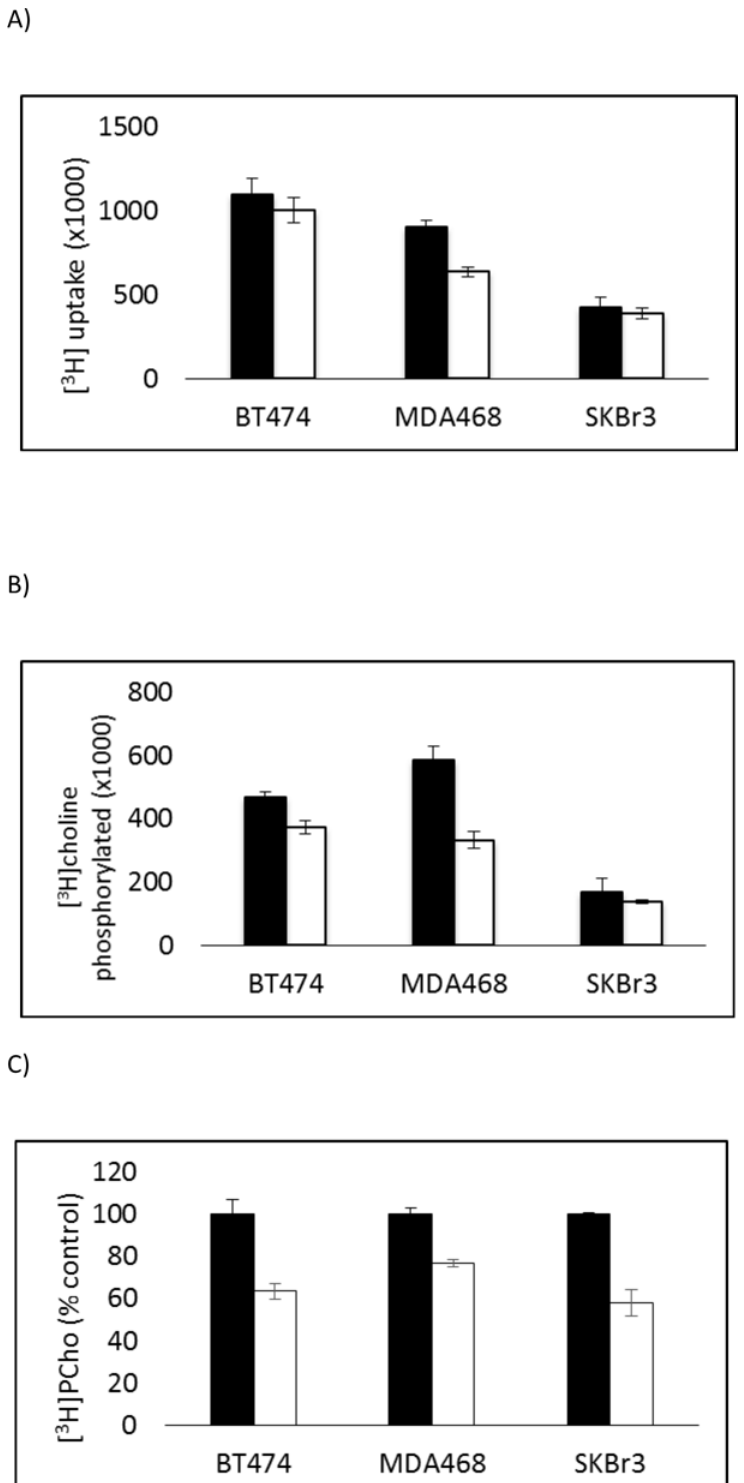
Fig 1. Total [ 3 H-methy]choline uptake (A), cellular phosphorylated [ 3 H-methy]choline (B) in untreated (solid) and metformin-treated (white) breast tumour cells incubated with [ 3 H-methyl]choline for 15min (Units: Radioactive counts normalised to protein content and expressed relative to untreated cells). Choline kinase